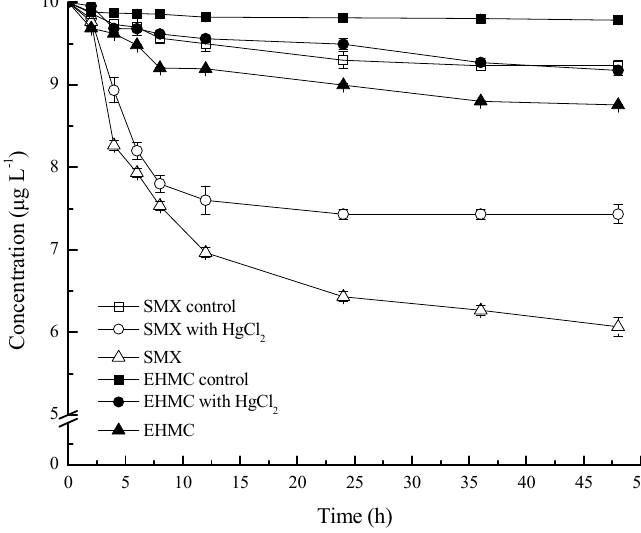
Figure 1. Temporal changes in the SMX and EHMC concentrations in water. The control group was no sediments; abiotic was the sediment containing HgCl 2 ; biotic was the sediment with untreated. The values are the means and the error bars represent the standard deviations (n = 3).